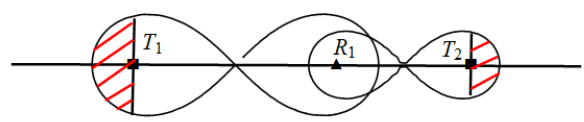
Figure 14. External coverage area of heterogeneous BR sequence ( T 1 , T 2 ) when d 1